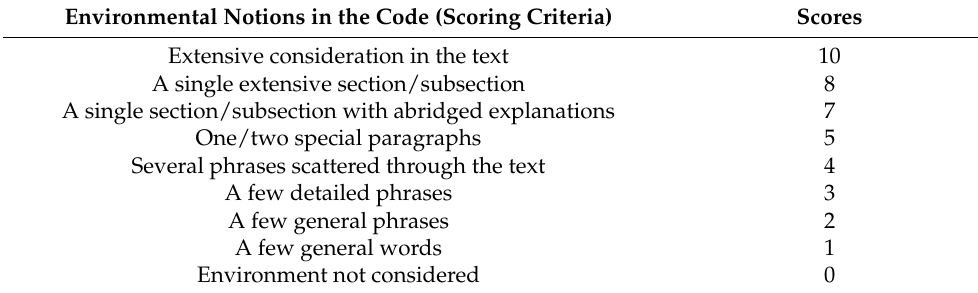
Table 2. Criteria for semi-quantitative environmental assessment of the analyzed codes of